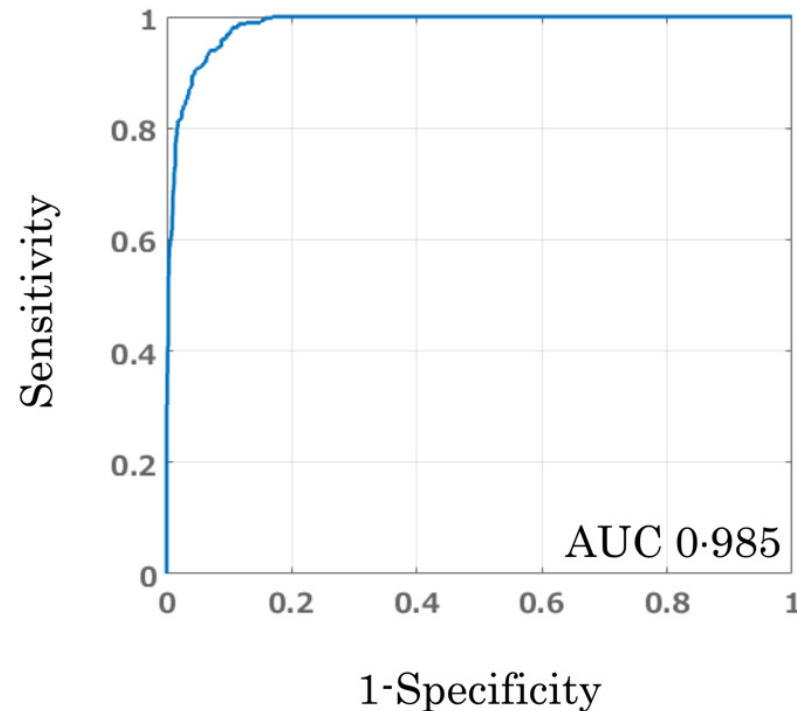
Figure 2. ROC curve for area-weighted diagnostic performance.